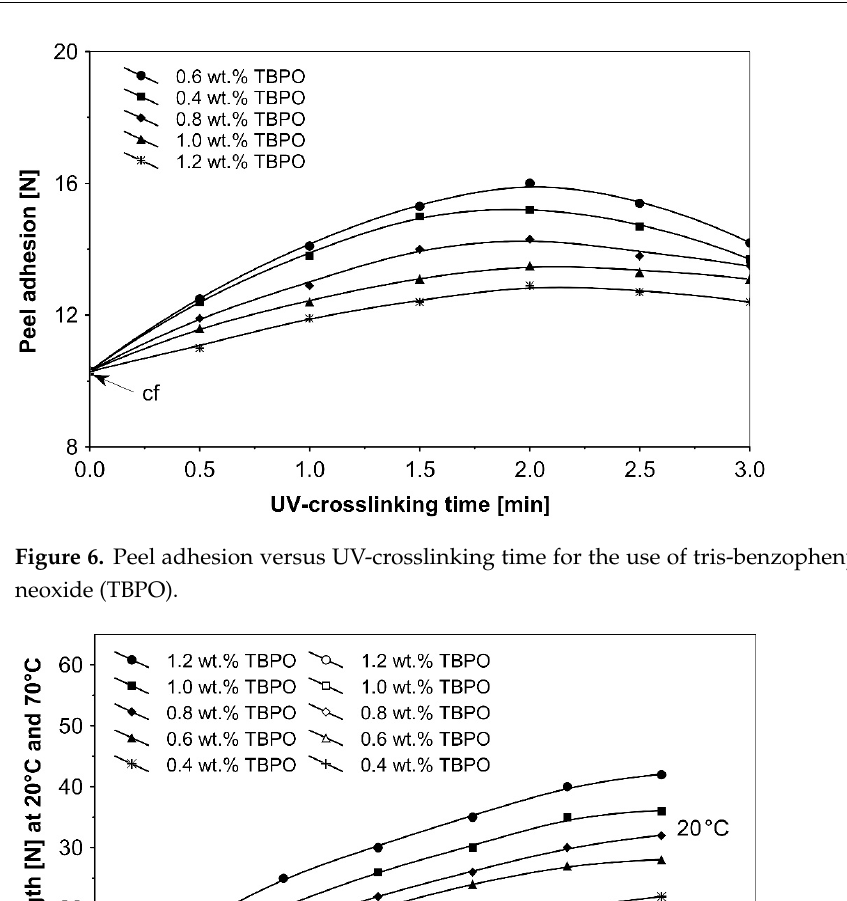
Figure 9. Peel adhesion versus UV dose for the use of tris ‐ benzophenyloxy phosphineoxide (TBPO).